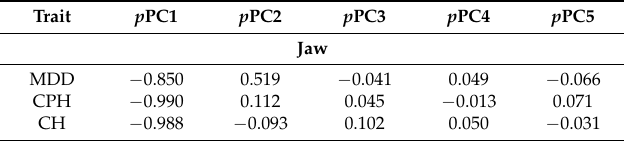
Table 1. Factor loads for the Phylogenetic Principal Component Analysis ( p PCA) of morphometric variables of jaw and skull of frugivorous bats of Stenodermatinae and Carollinae subfamilies of Phyllostomidae. Total skull length (TSL), Postorbital Width (PW), Zygomatic Breadth (ZB),